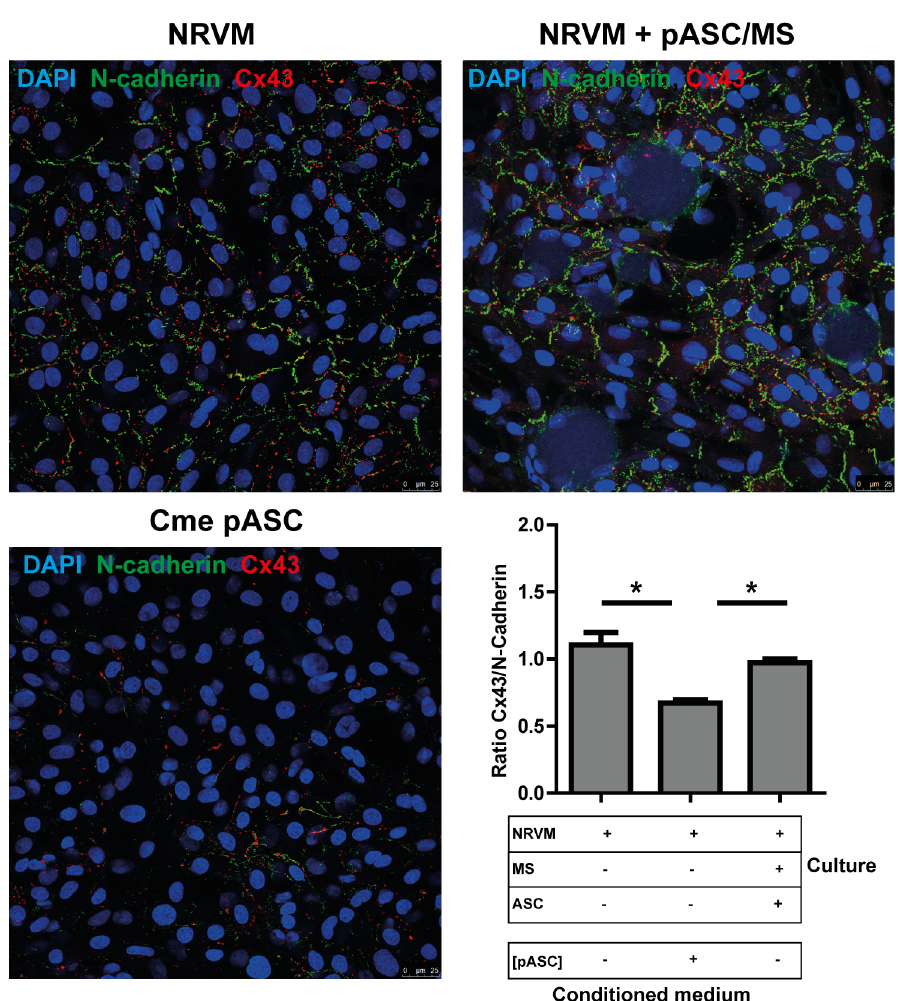
Fig 8. Immunofluorescencemicrographs of cultures stained with N-cadherin and Cx43. A: A monolayerof NRVM, a monolayerof NRVM culturedin pASC conditioned medium and a monolayerof NRVM co-cultured with pASC loadedmicrospheres are stainedfor N-Cadherin and Cx43. B: The ratio of Cx43: N-Cadherin in the variouscultures, determinedby the number of pixels. Ratios are basedon 5–10 images taken in each of three independent cultures. * indicatesp < 0.05. Abbreviations; Cme: conditionedmedium, Cx43: connexin43, MS: microspheres, NRVM: neonatal rat ventricular myocytes and pASC: porcine adipose tissue-derived stromal